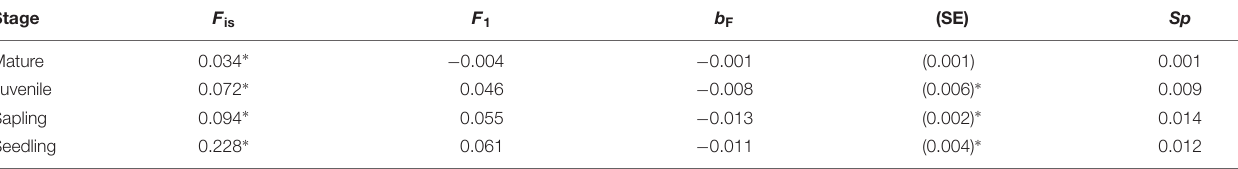
TABLE 3 | Genetic parameters of inbreeding and spatial genetic structure for the different growth stages of Picea jezoensis. Stage F is F 1 b F (SE) Sp Mature (0.001)